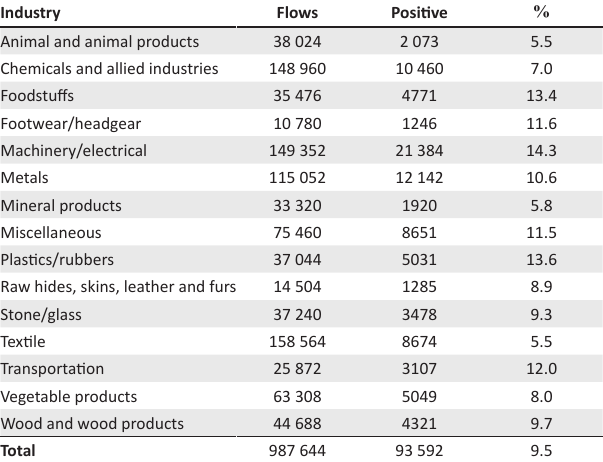
TABLE 2: Percentage of non-zero export flows by industry